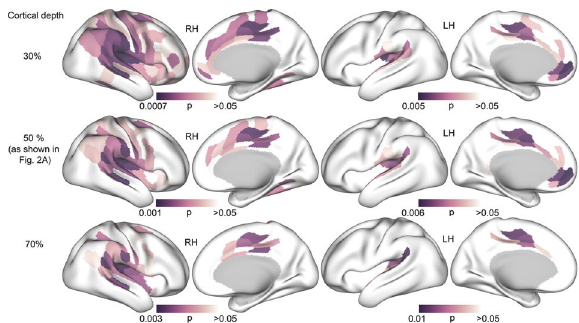
Fig. 5 Surface maps as a function of cortical depth ( p -values). Maps showing signi fi cant group differences in T 1 w/T 2 w ratio in the right hemisphere (RH, left side) and left hemisphere (LH, right side) for 30%, 50% and 70% cortical depth. Top row . T 1 w/T 2 w ratio sampled from 30% into the cortex from the white/grey matter boundary. Middle row . 50% cortical depth (as shown in Fig. 2A) . Bottom row . 70% cortical depth. Fig. S3, and the distribution of change values in Fig. S4. The change in subjective sleepiness differed between the groups (see Table 1), with the sleep deprived group showing increased sleepiness (higher KSS) at TP2. There was no group difference in